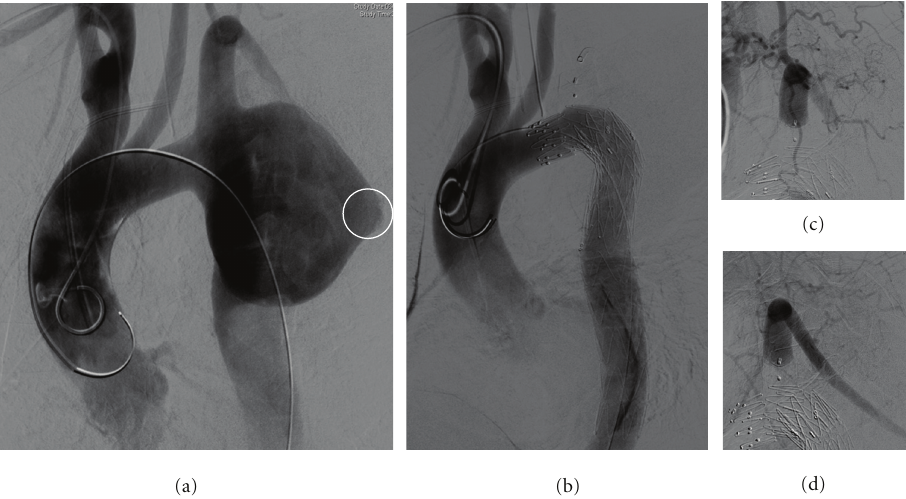
Figure 2: (a) Angiography shows a large aortic pseudoaneurysm extending to the origin of the left subclavian artery with an irregular wall (white circle). (b) Final angiography after stent placement and embolization of the left subclavian artery demonstrates complete exclusion of the pseudoaneurysm with no evidence of leakage. (c) and (d) Late angiographic image shows left subclavian artery perfusion due to subclavian steal.